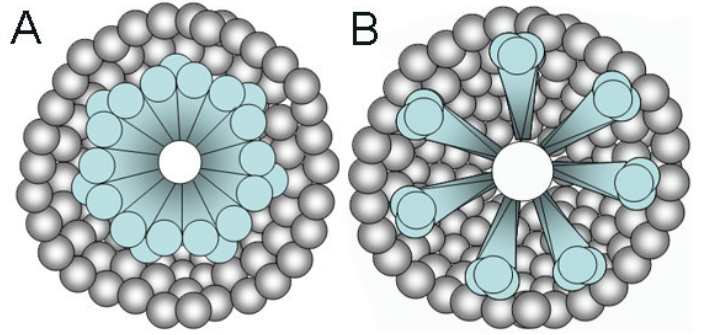
FIGURE 4 . Top view of two models of details of the fusion pore in a lipid bilayer. Proteins are the light blue and lipids are the gray circles. (A) Lipids are prevented from mixing between the two membranes by a tight collar assembled from several fusion proteins. (B) The assembly of transmembrane domains of multiple fusion proteins at the fusion pore is loose enough to allow lipids to diffuse between the two